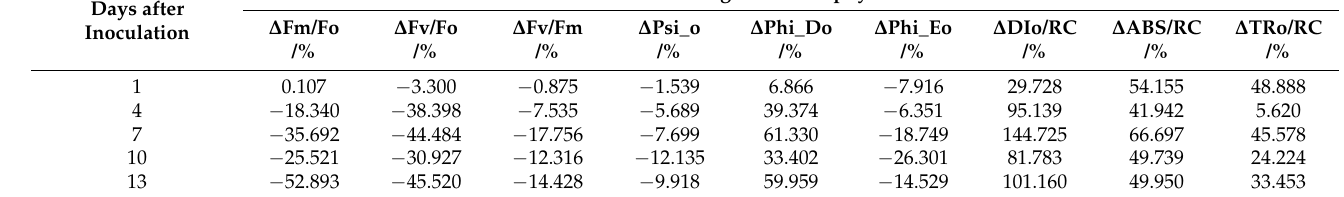
Table 2. The relative rates of change in chlorophyll fluorescence parameters of P. thunbergii after inoculation with PWN.